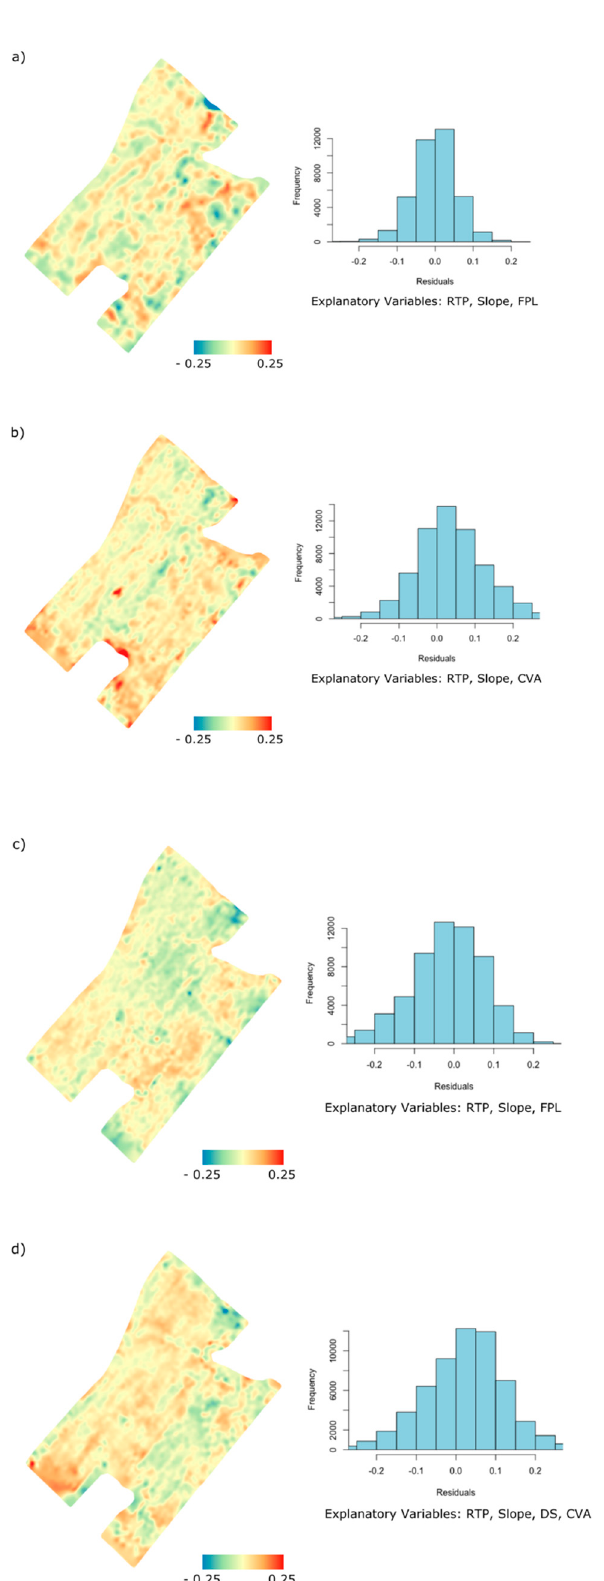
Figure 5. Spatially plotted predicted crop yield residuals and included explanatory variables for ( a ) average of all crops; ( b ) corn; ( c ) winter wheat; ( d ) soybeans.